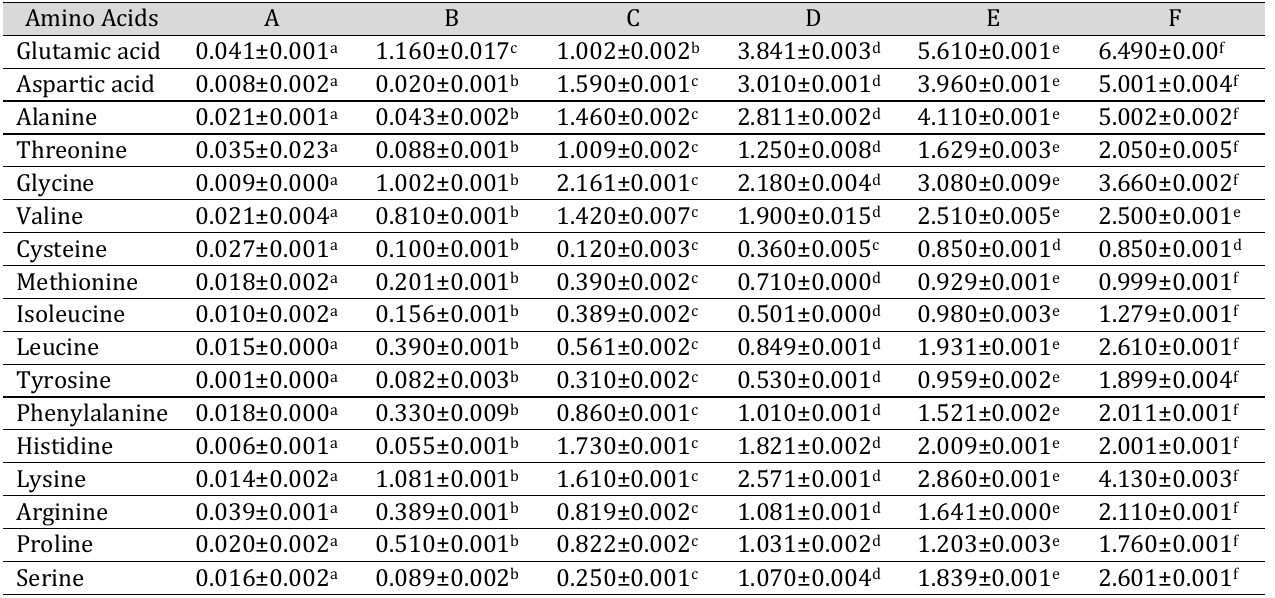
Table 3. Amino acid composition of raw Cassava-African yam bean blends (g/100g).